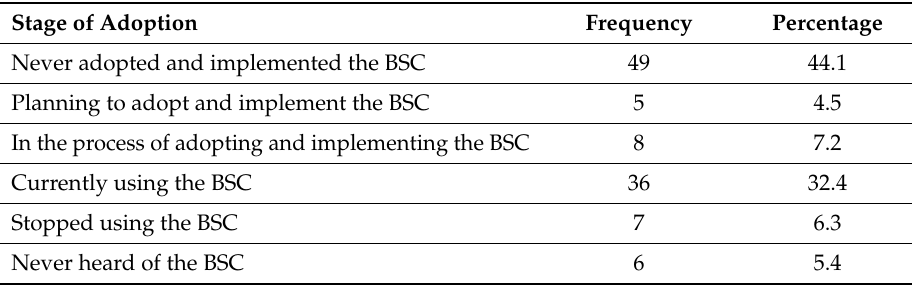
Table 6. Stage of adoption and implementation (N =